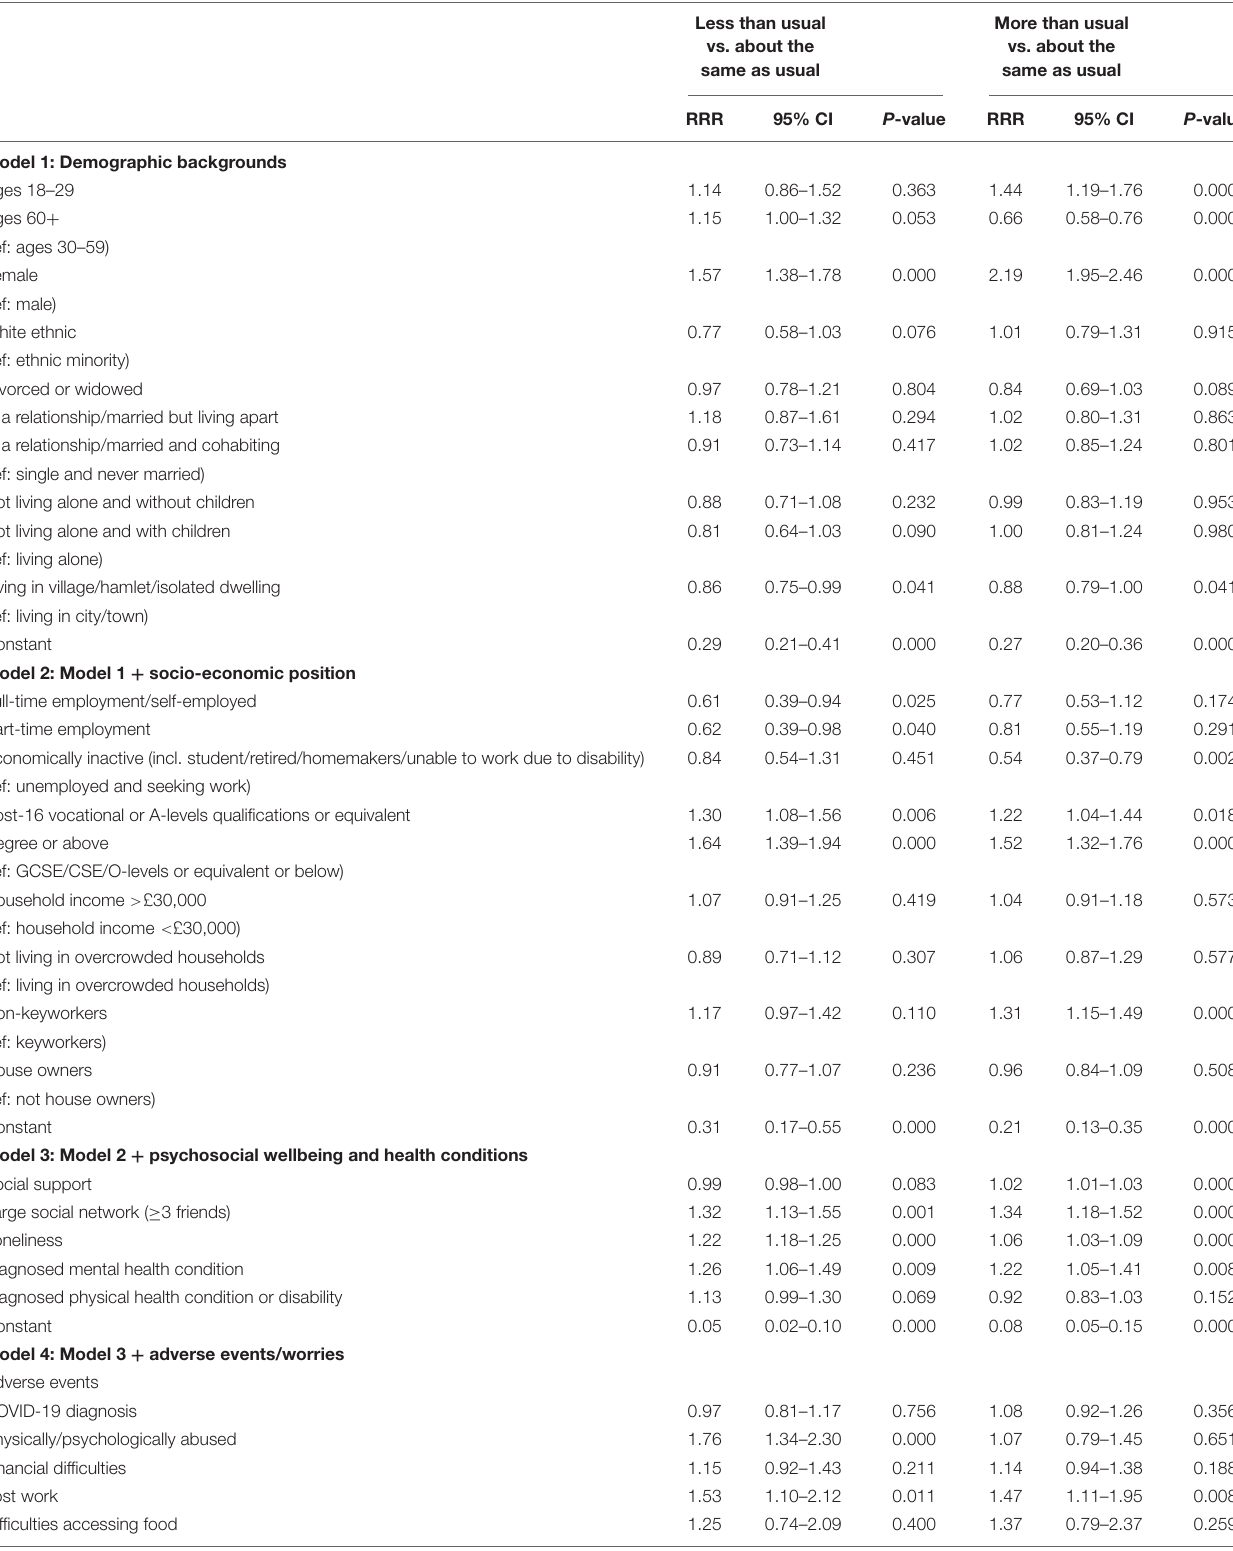
TABLE 4 | Multinomial logistic regression predicting the amount of arts engagement in April/May during the COVID-19 pandemic compared to usual amount (prior to the pandemic) (weighted; N = 19,384).